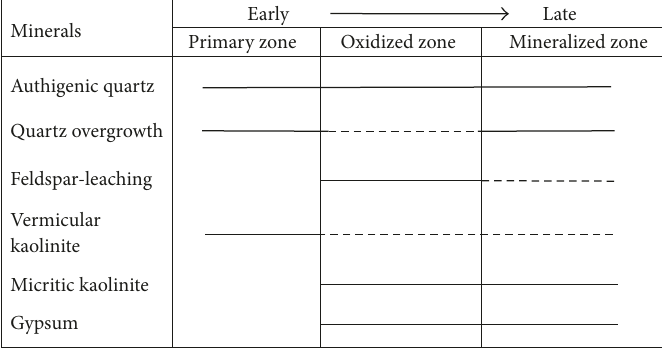
Figure 4: Paragenetic sequence of the Mengqiguer uranium